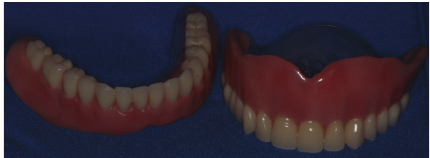
Figure 3: New complete dentures.